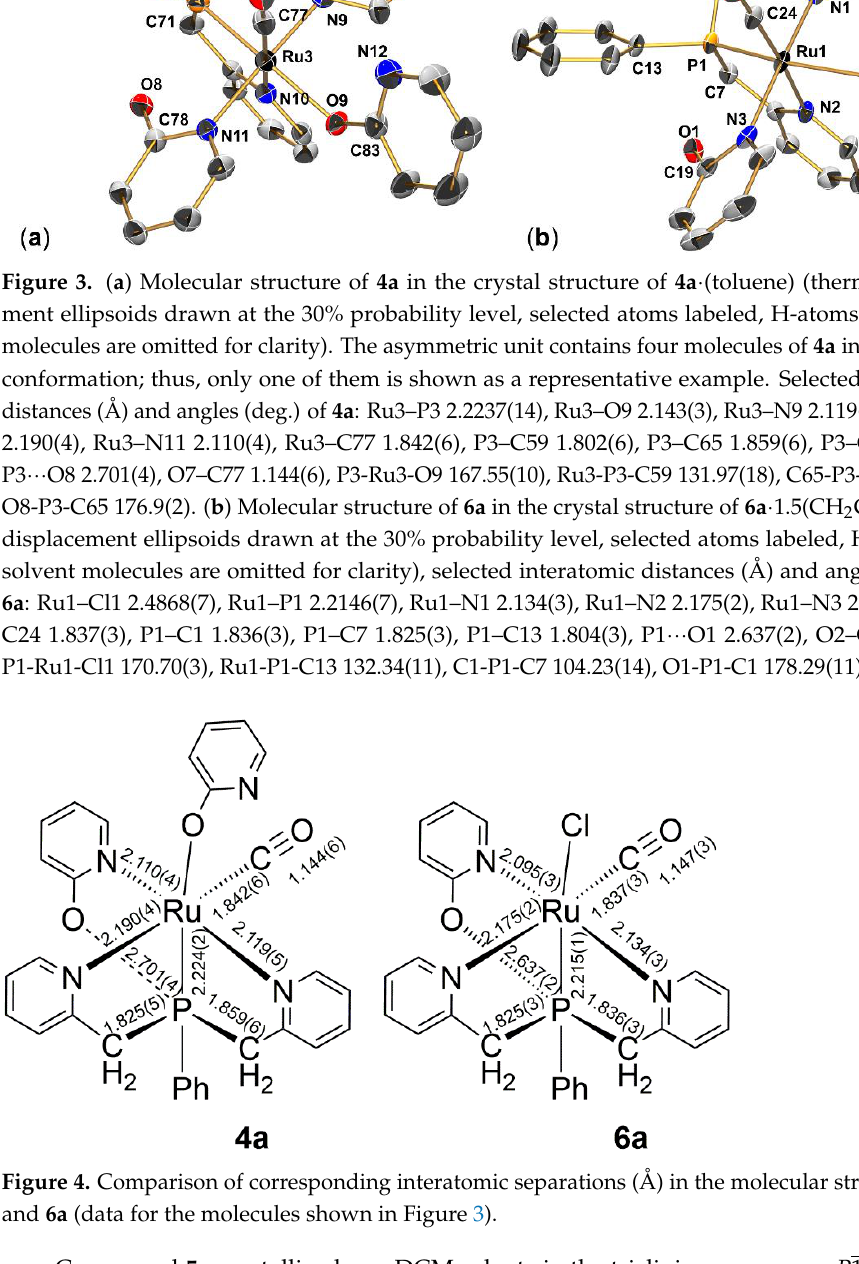
Figure 4. Comparison of corresponding interatomic separations (Å ) in the molecular structures of 4a and 6a (data for the molecules shown in Figure 3). and 6a (data for the molecules shown in Figure